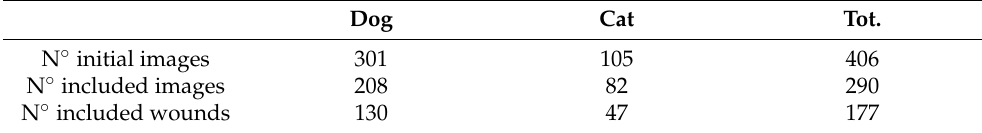
Table 1. Description of the images involved in the study. The number of images is split according to the pet species of the patients. The three rows of the table show the number of initial images collected; the number of images after exclusion of inadequate ones; the different wounds considered starting from the included images, since the same wound could have been acquired at different time points in dogs and cats. Dog Cat Tot.